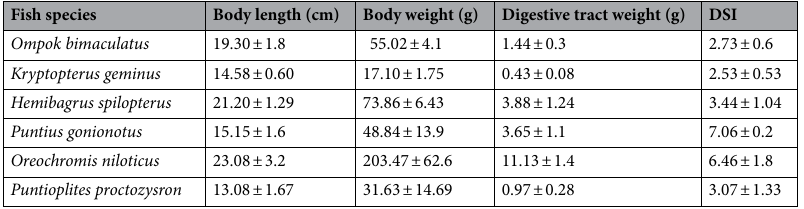
Table 1. Data of body length, body weight, digestive tract weight, and calculated digestive somatic index of fishes. Values are mean ± SEM of five to eight specimens of each fish